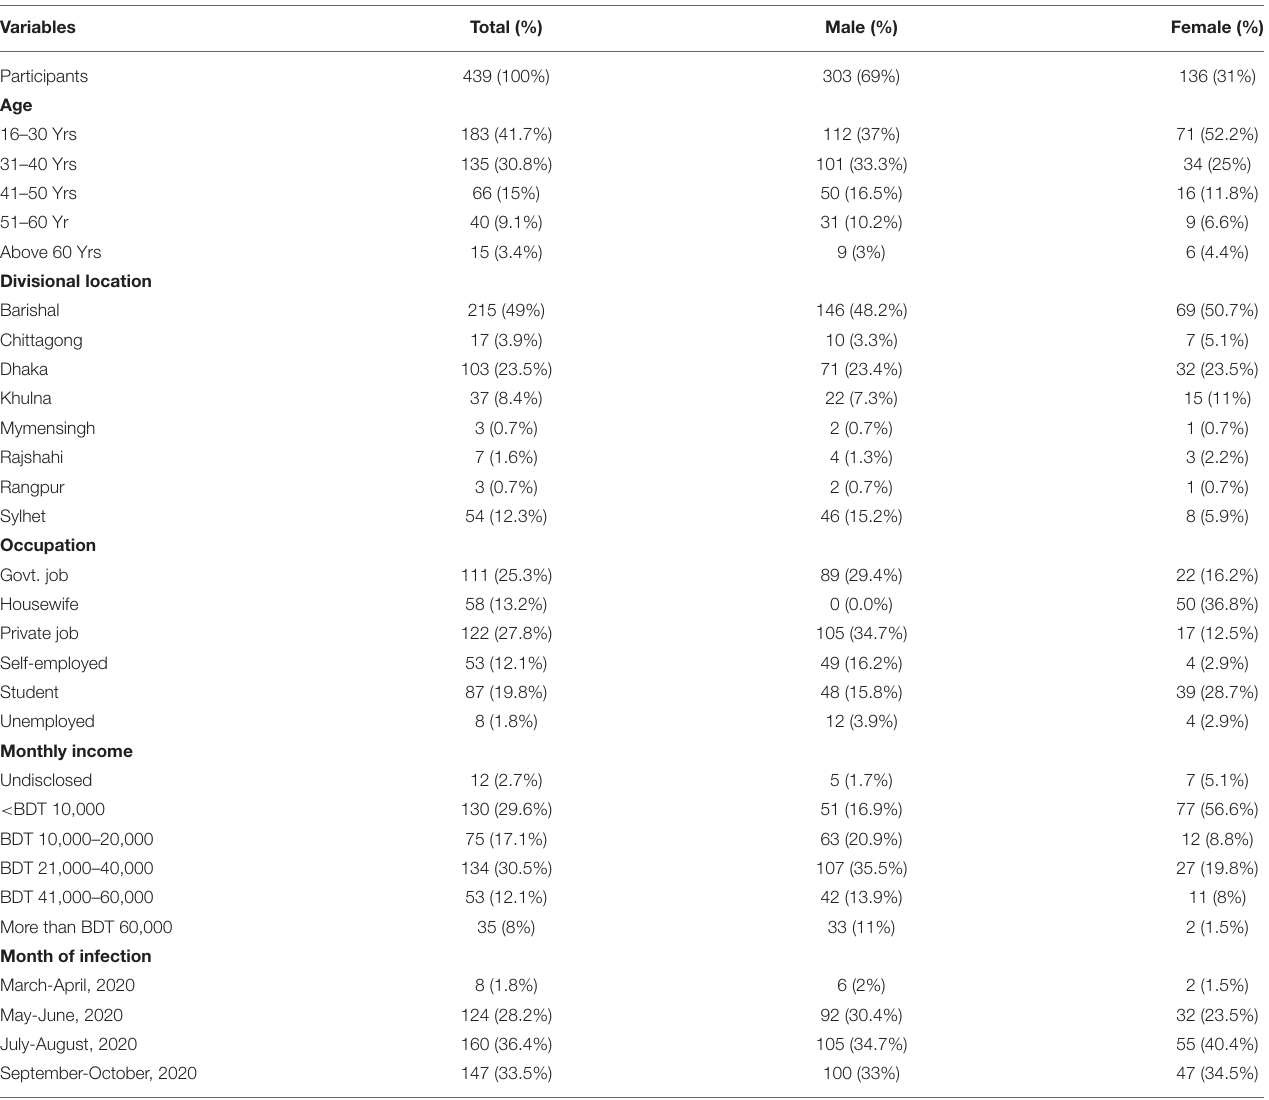
TABLE 1 | Demographic distribution of the participants, Bangladesh, 2020.